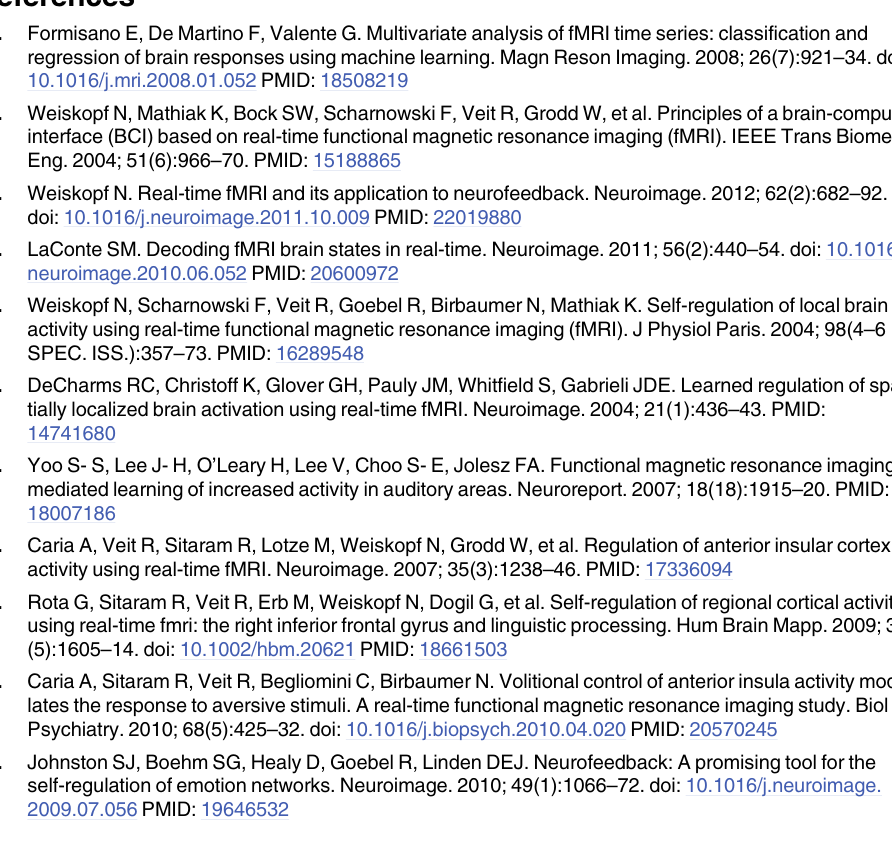
S1 Table. Summary of whole-brain regions activated during visual motion imagery. Peak voxels according Talairach coordinates and the number of used voxels (FFX, q(FDR) = 0.05 using the contrast up-regulation tasks versus down-regulation task. Results presented per imagery run: passive imagery run (control run without feedback), imagery runs with feedback (neurofeedback 1 and 2, NF1 and NF2) and transfer